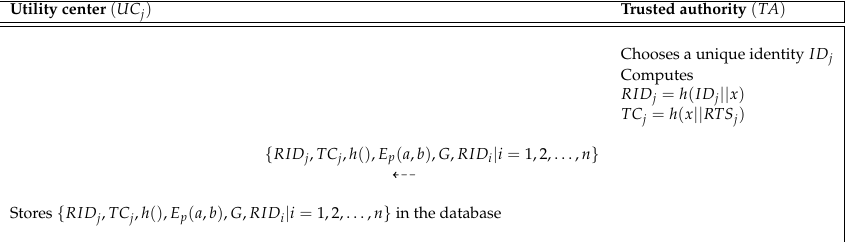
Figure 4. Utility center registration process of Kumar et al.’s